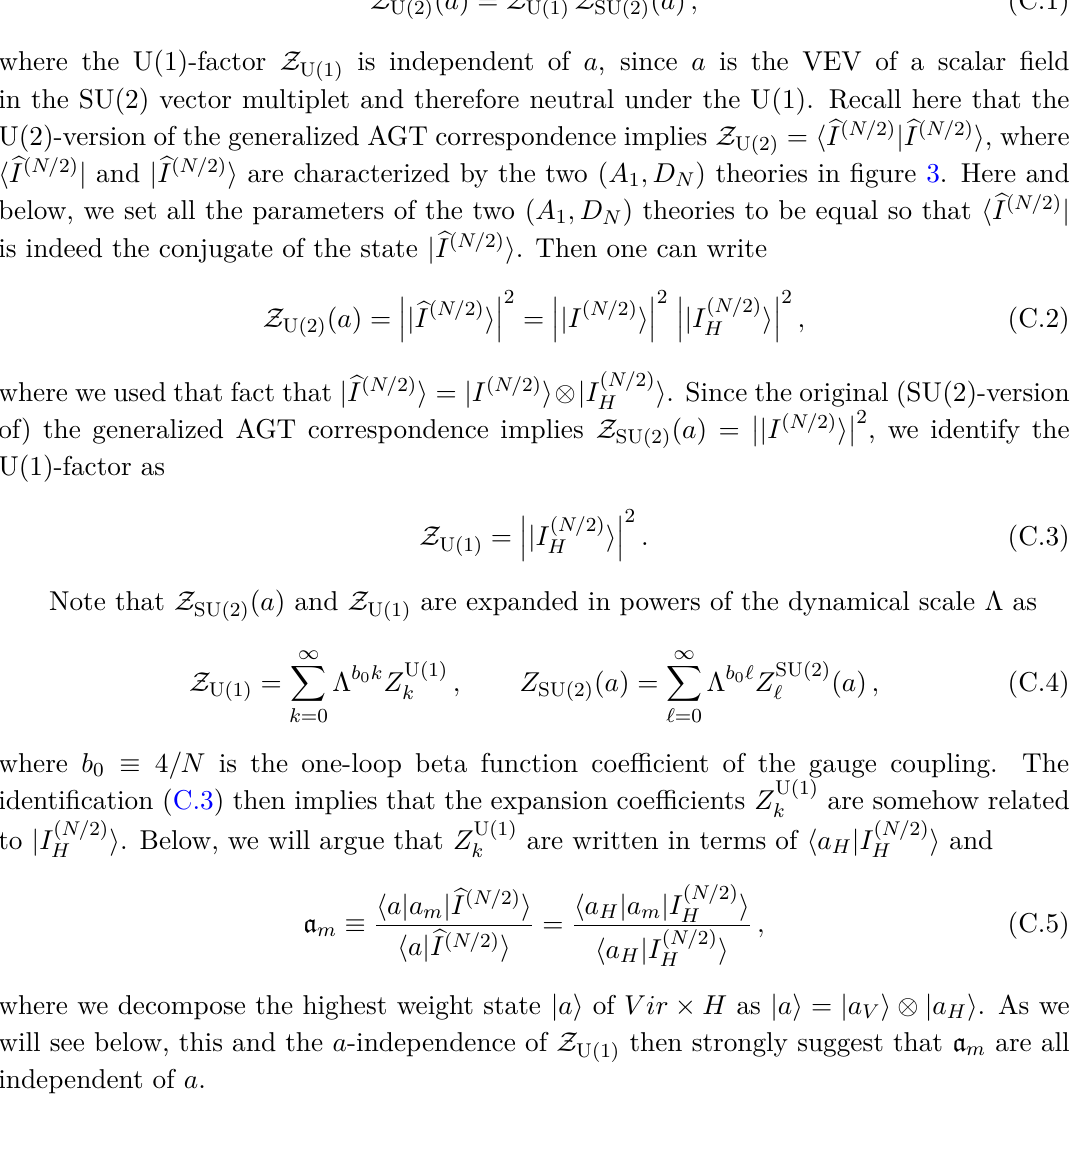
Figure 4 . The mass deformed theory of the ( A 2 , A 5 )